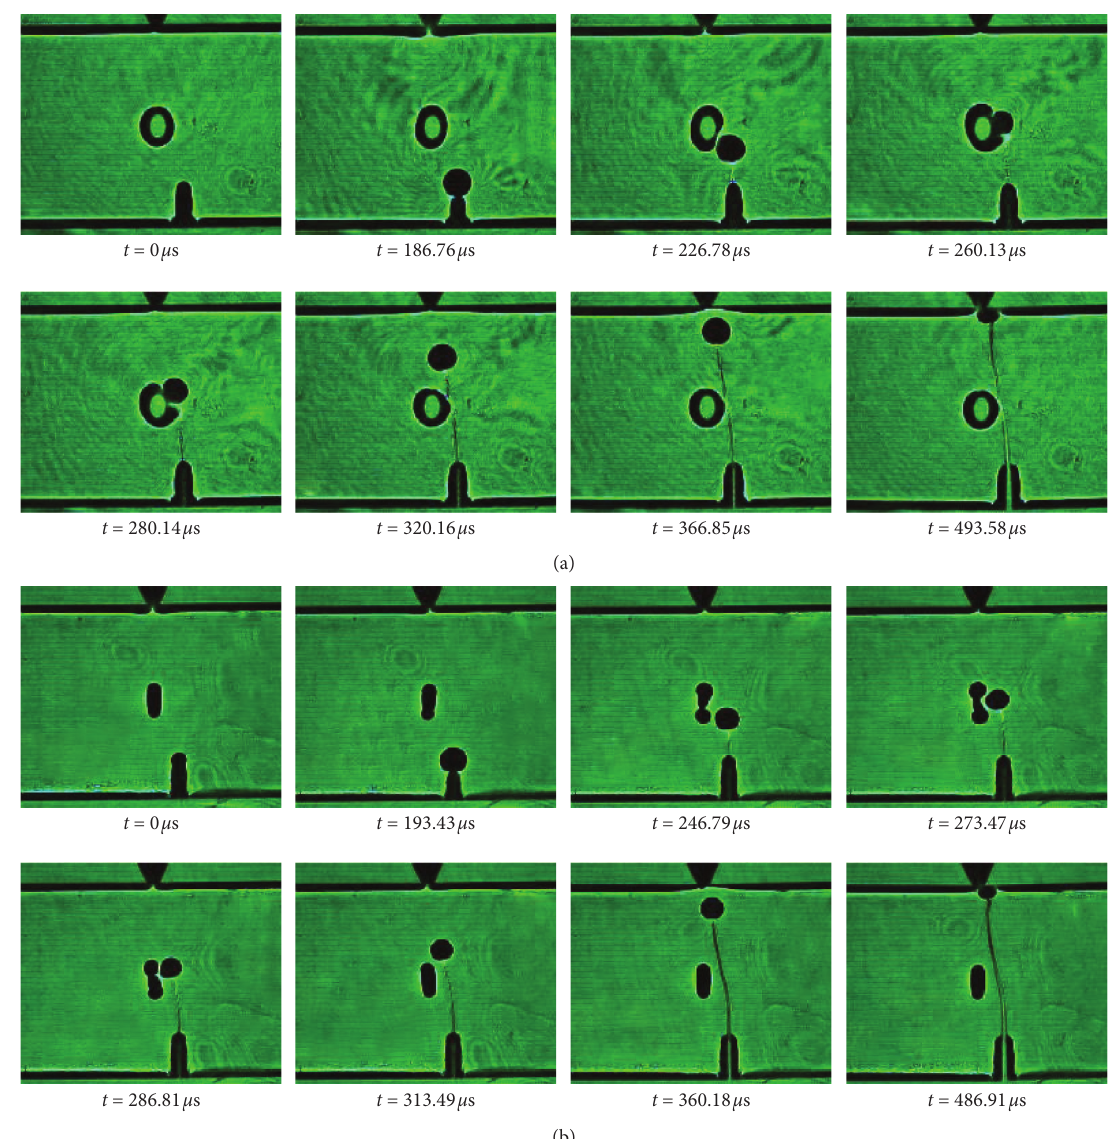
Figure 8: Dynamic caustic spots of specimens. (a) Specimen S